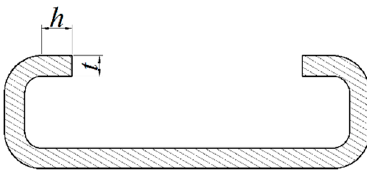
Figure 6. The cross-section of the concave ring.